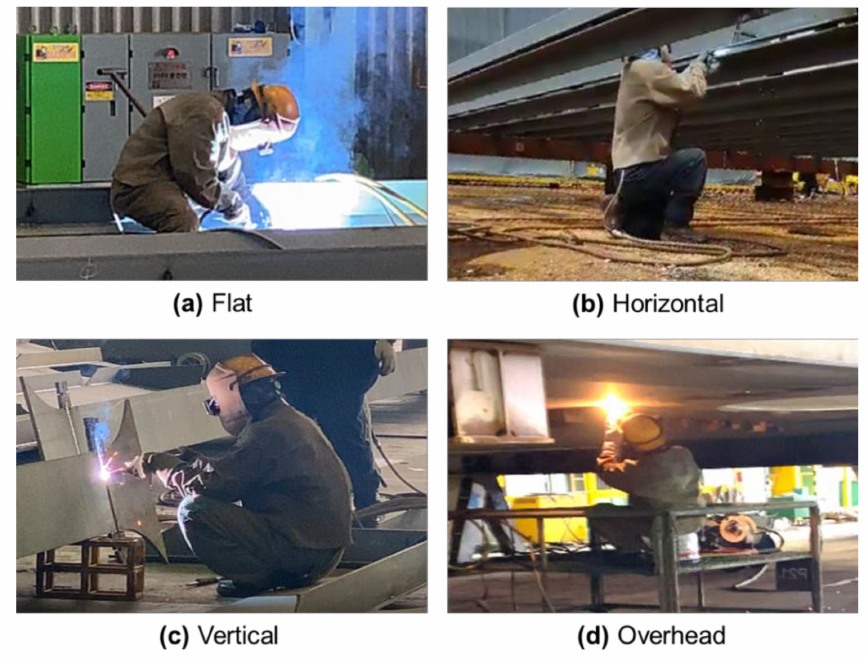
Figure 2. Various welding positions observed in block assembly processes.